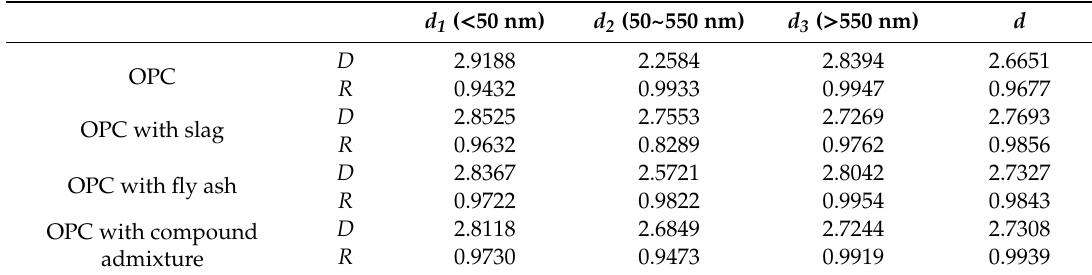
Table 6. Fractal dimension of pores and correlation coe ffi